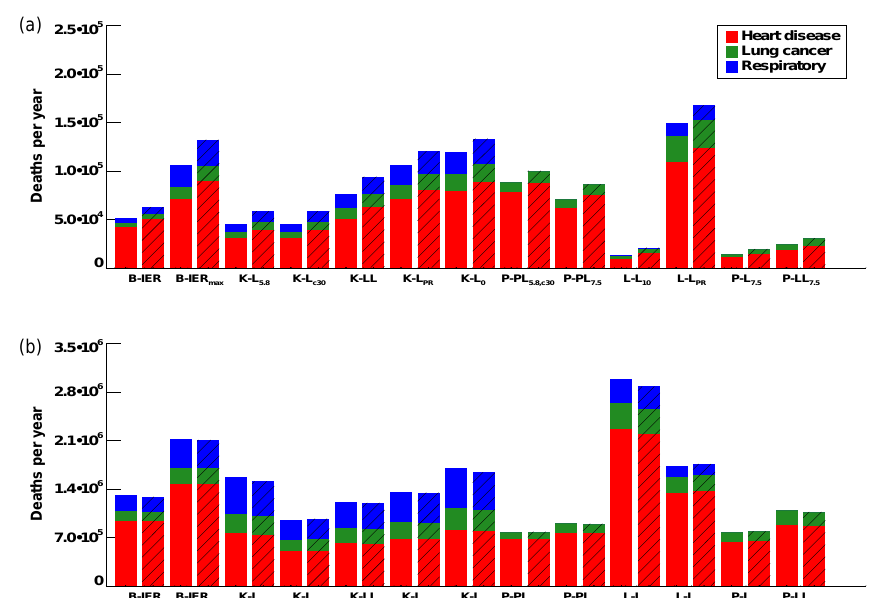
Figure 9. Premature mortality estimates for (a) the US and (b) China determined using different RR, CRFs, and threshold/ceiling values, as described in Table 3. Colors represent cause of death estimated using PM 2 . 5 concentrations from unconstrained model simulations (solid) and satellite-based estimates